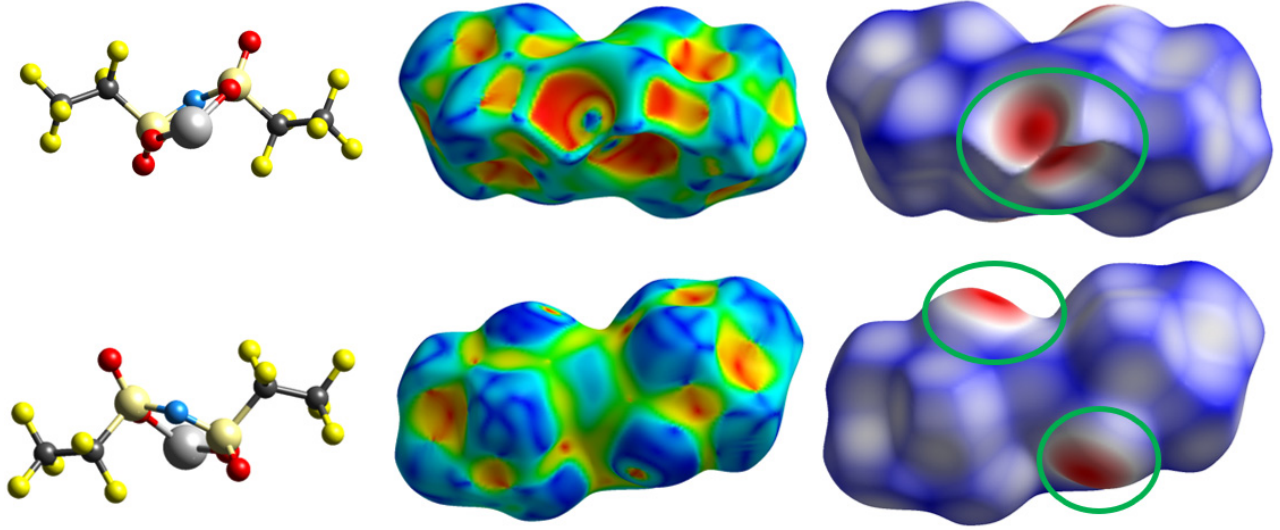
Figure 6. Depiction of the [Li{BETI}] structure ( left ) and the Hirshfeld surfaces for [Li{BETI}] mapped with the shape index ( middle ) and d norm ( right ). Green circles indicate the connection points for the oxygen atoms to adjacent lithium ions.